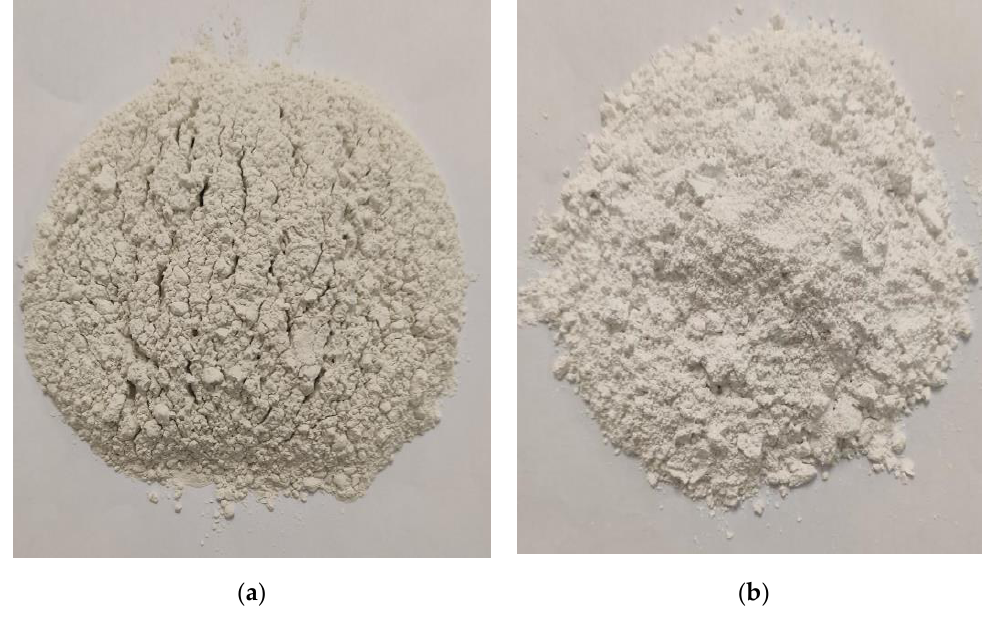
Figure 1. White Portland cement powder ( a ) and GLP ( b ). Table 1. Technical data of white Portland cement. Table 2. Chemical composition of white Portland cement and GLP (%).